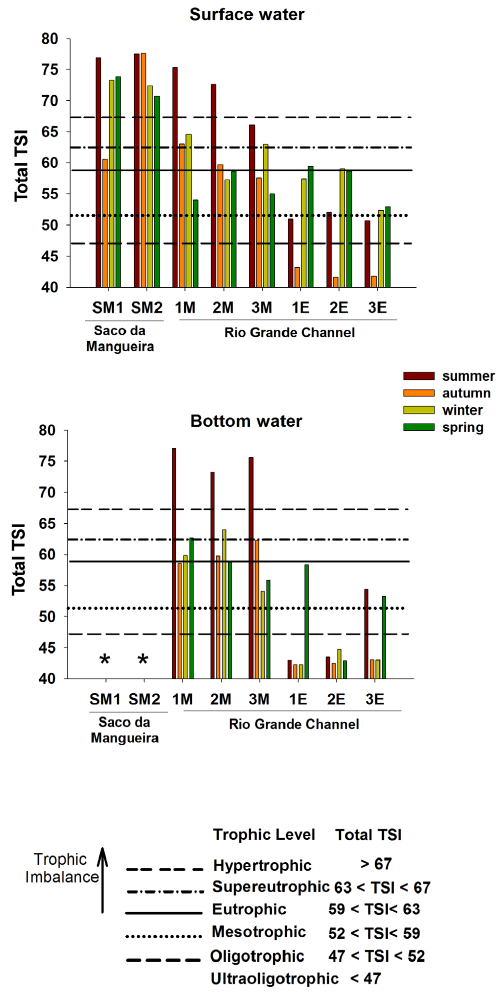
Figure 4. Seasonal variation of the total Trophic State Index (total TSI) at the margin of Saco da Mangueira (sites SM1 and SM2) and in the Rio Grande Channel, at the margin (sites 1M, 2M and 3M) and in the channel (sites 1E, 2E and 3E) in 2011. * Data are absent because of the low depth in the